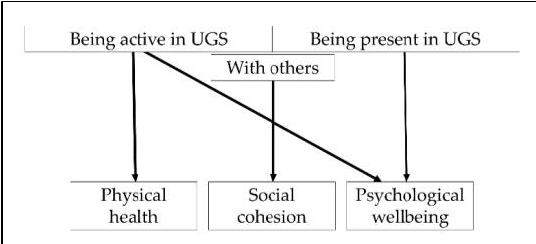
Figure 1. Model for assessing the health benefits of UGS and how they relate to the way it is used.